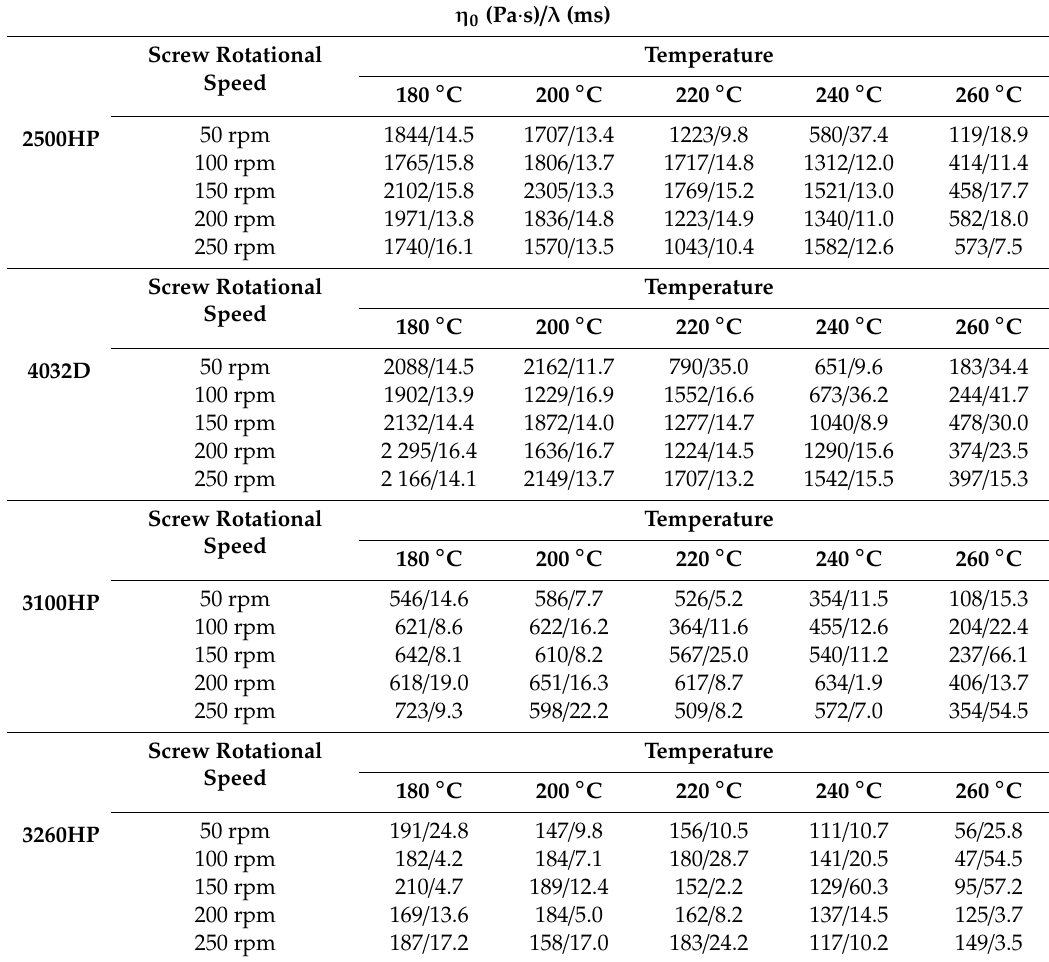
Table 4. Zero shear viscosity and characteristic relaxation